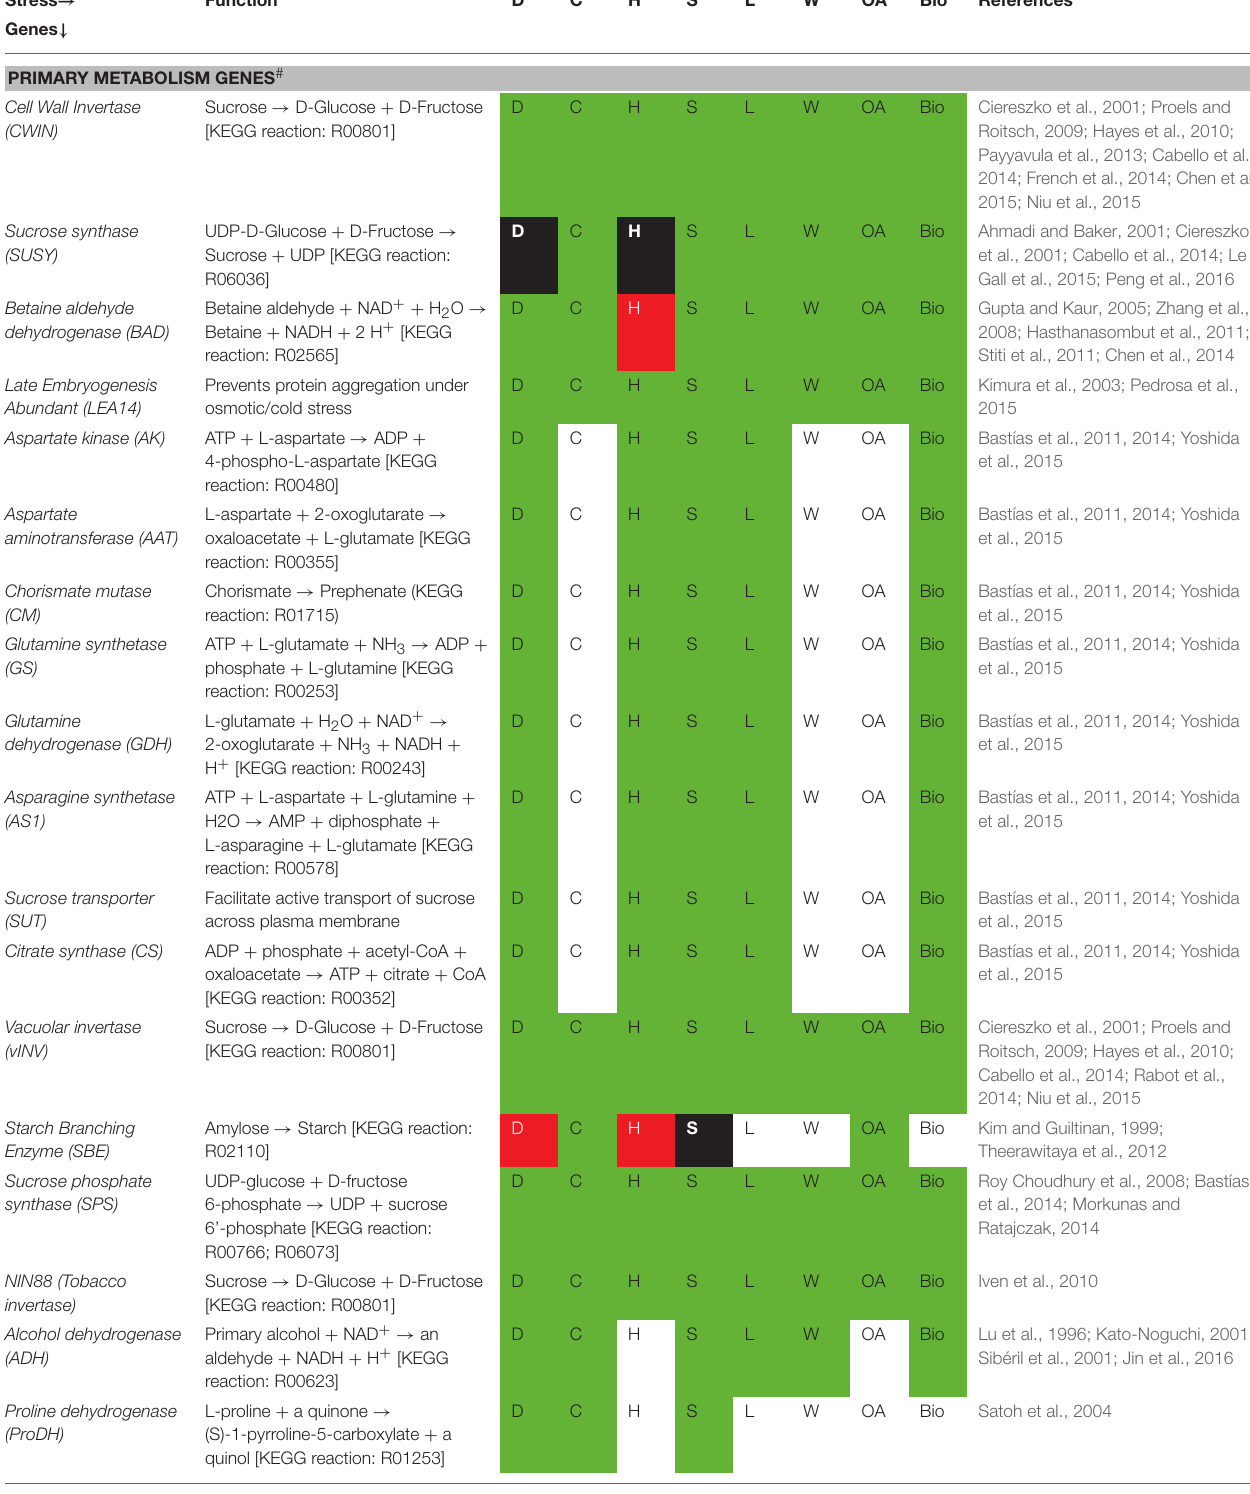
TABLE 1 | Predominant primary metabolism, specialized metabolism and TF genes coregulated under similar stress conditions. Stress